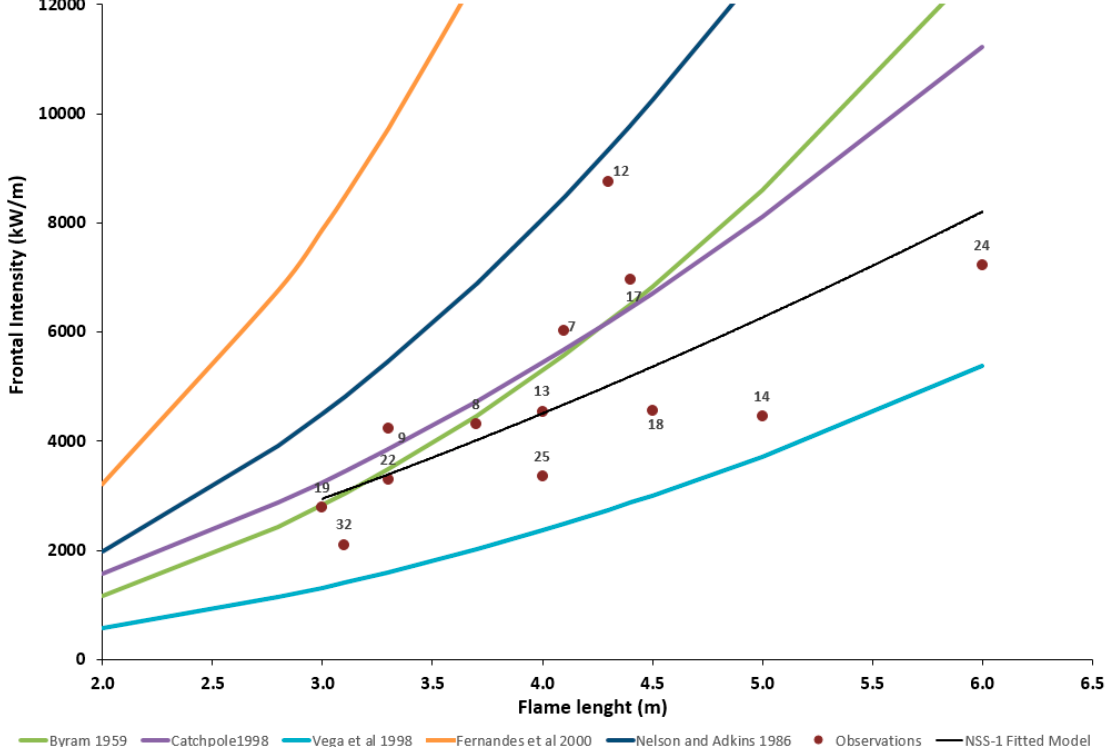
Figure 8. Observed flame lengths (m) and fireline intensity (in kW/m as calculated by Byram’s equation (Equation (2)) along with several existing relationships from other studies.